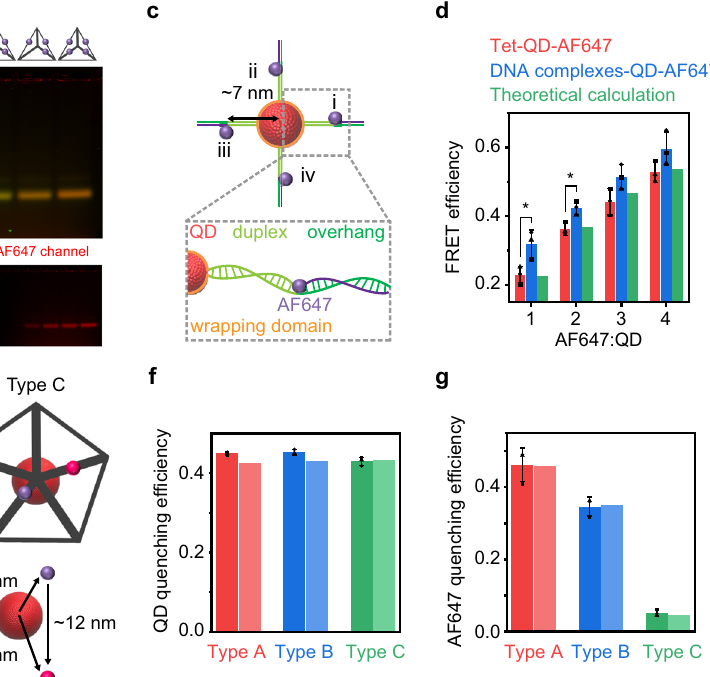
Fig. 5 | Valence-geocodedQD-basedenergy transfer circuits. a Schematicof the Tet-QD-based FRET network and the overhang design (the distance for each de- excitation pathway is ~7nm). b AGE (1.5%) image for 1 – 4 AF647-labeled Tet wire- frame DNA origami objects. (Green: SYBR safe channel, Red: AF647 channel). c Schematic of the DNA complex-QD-based FRET network. d FRET ef fi ciencies as a function of acceptors calculated from the Tet-QD-dye system, the DNA complex- QD-dye system, and Förster theory (Eq. (5)). P values are from Student ’ s t test